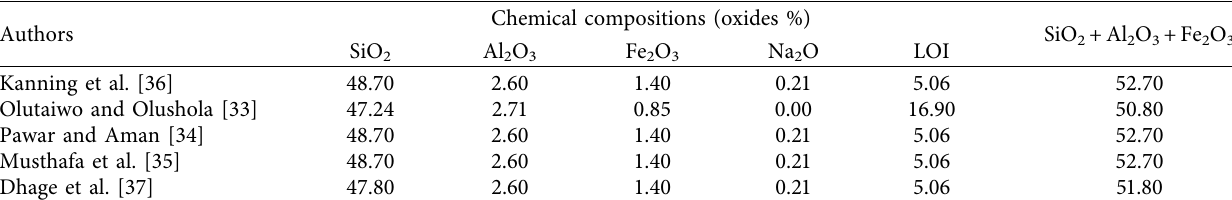
Table 2: Chemical composition of banana leaves’ ashes (BNLA).